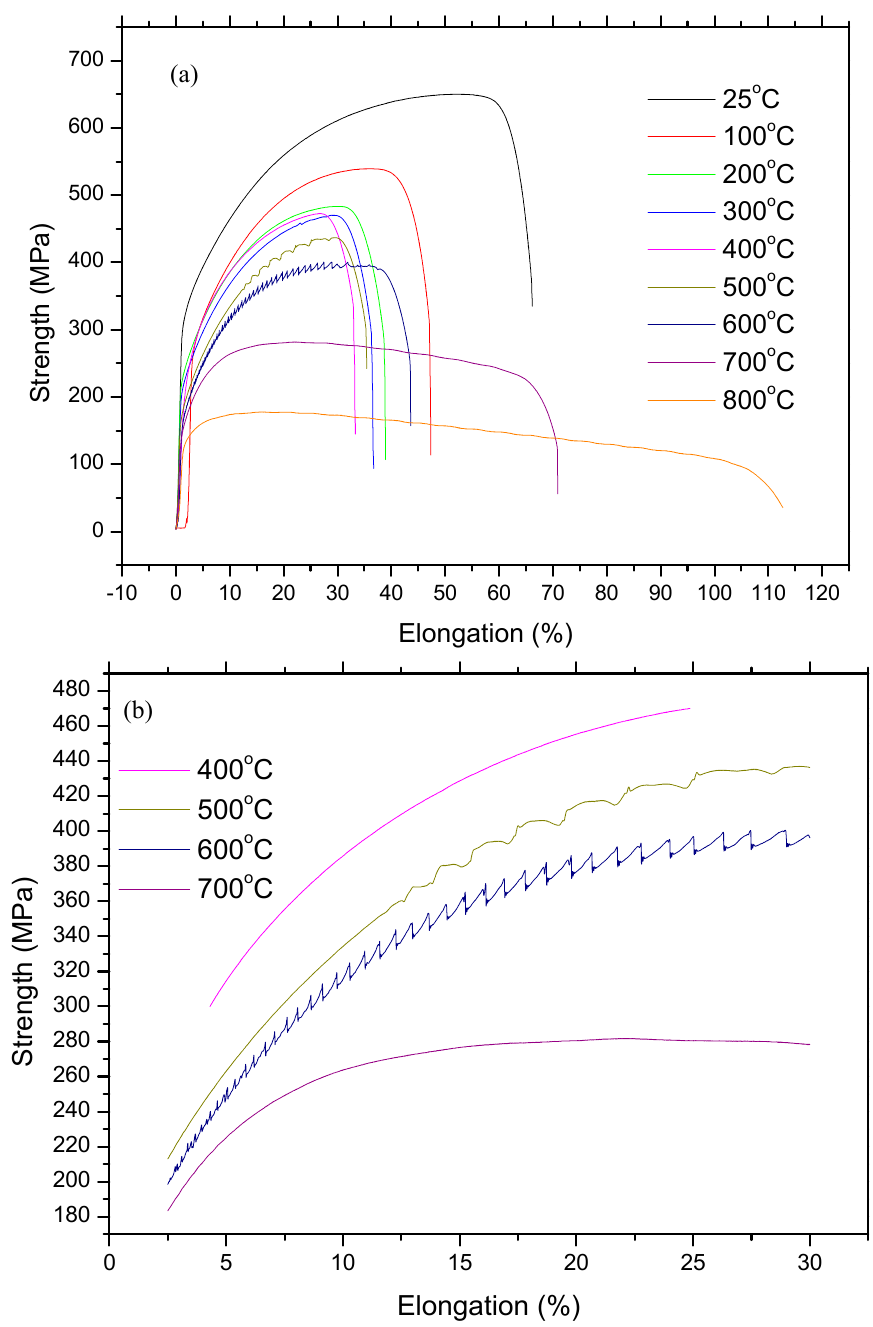
Figure 4. Stress and strain diagrams of as-received samples: ( a ) full range profiles and ( b ) sections in large scala.